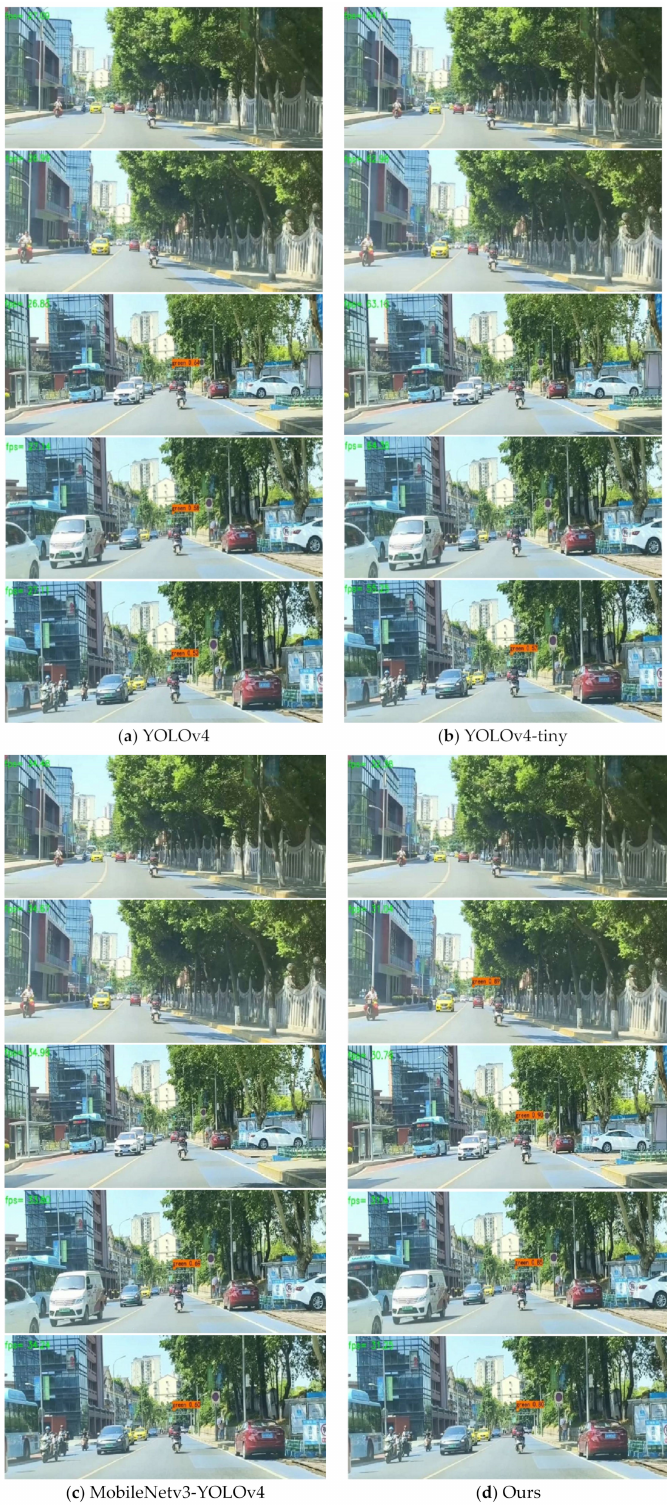
Figure 13. Comparisons of real-vehicle test results for different algorithms. As can be perceived from Figure 13, the distance that the proposed algorithm achieves accurate and stable detection is the farthest, followed by YOLOv4 and MobileNetv3- YOLOv4. YOLOv4-tiny has the worst